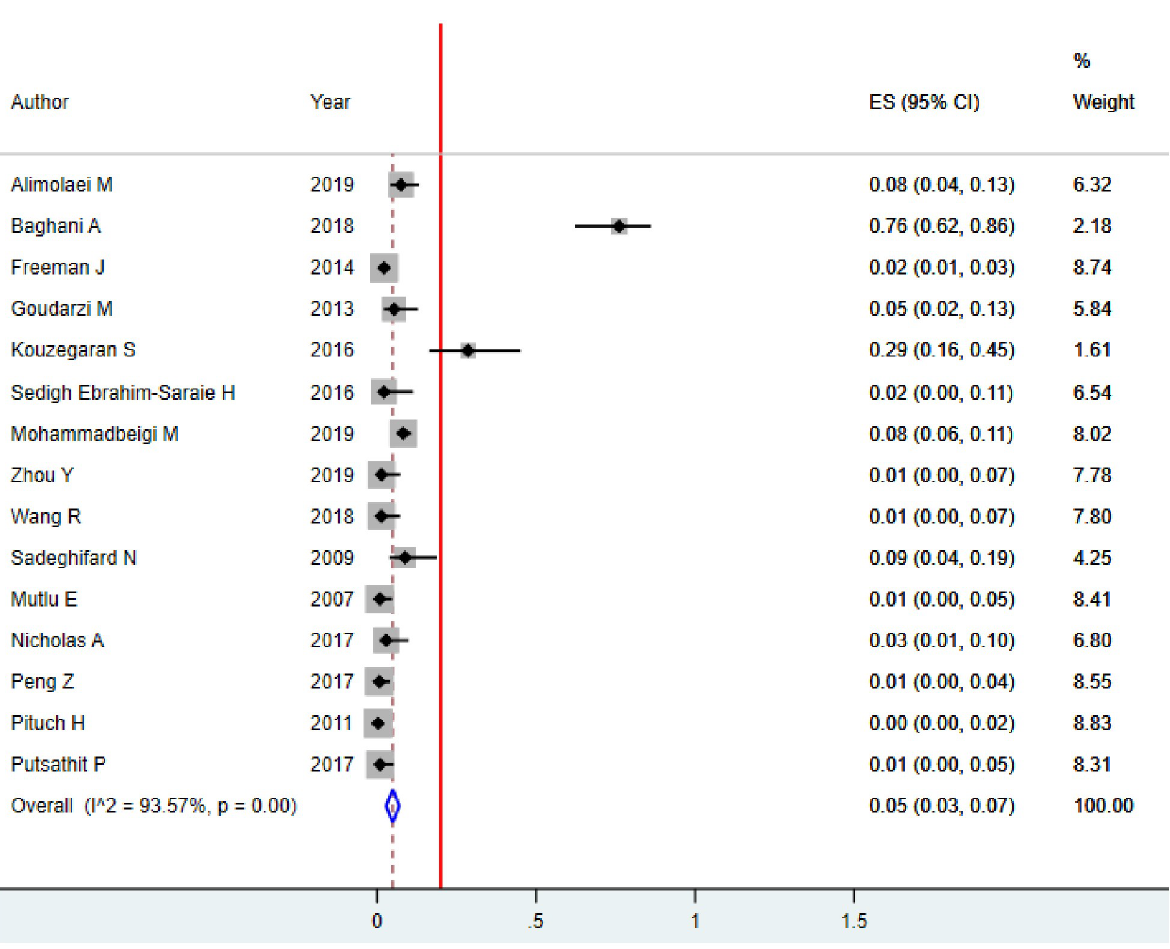
PLOS ONE | https://doi.org/10.1371/journal.pone.0262597 January 13,